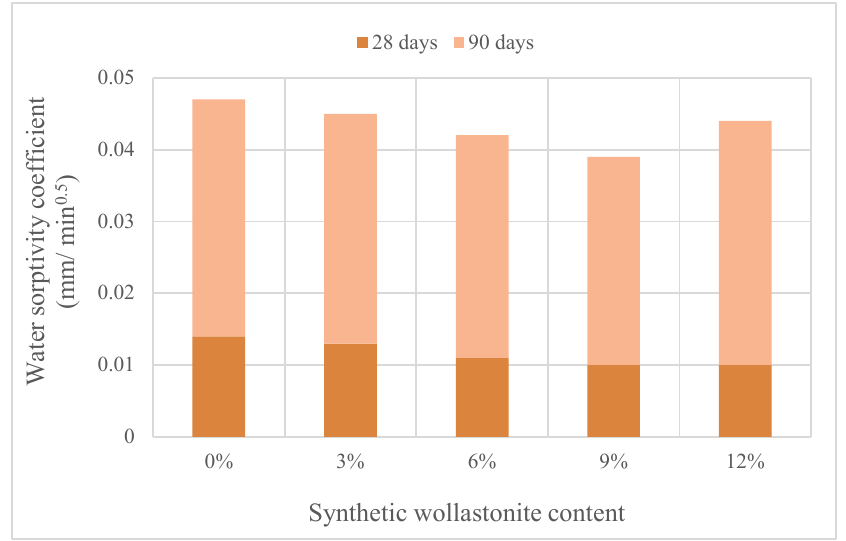
Figure 7. The water sorptivity coefficient and synthetic wollastonite content based on Ref. [7].